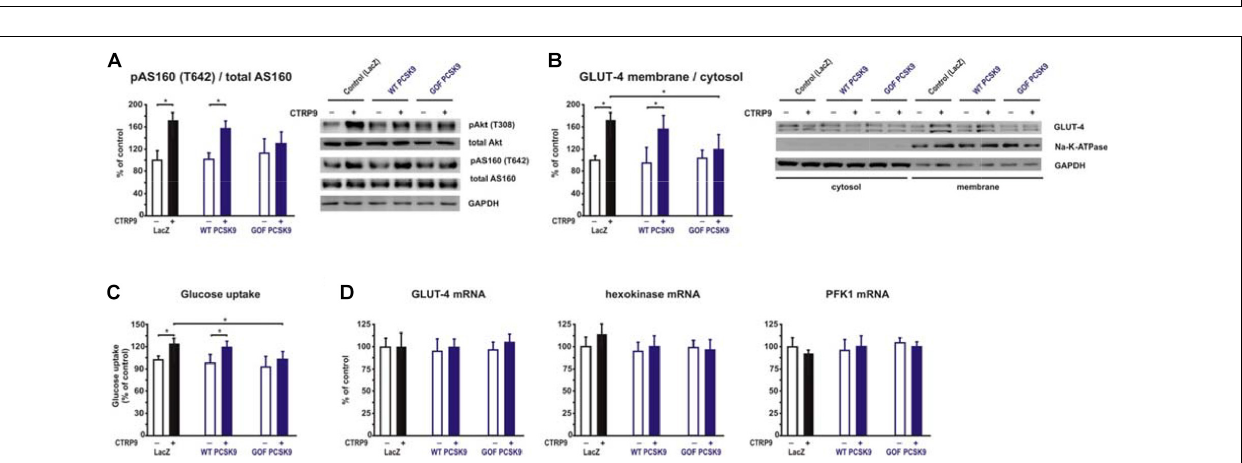
FIGURE 6 | Impact of PCSK9 on CTPR9-induced mitochondrial effects. Adult rat cardiomyocytes were incubated in the presence of LacZ-containing supernatant (control), murine wild-type PCSK9 or GOF PCSK9 (each 0.5 µ g/ml) in serum-free medium for 24 h and subsequently treated with CTRP9 (4 µ g/ml) for 24 h. (A) Changes in PGC1alpha, Tfam, and ND1 mRNA expression were analyzed by Real-time PCR. (B) Genomic DNA was isolated from the cells and afterward analyzed by Real-time PCR for the expression of a mitochondrial transcript and a nuclear transcript in order to estimate mtDNA content. (C) Citrate synthase (CS) activity and the activity of complex I, complex II and complex IV of the respiratory chain were measured in cardiomyocyte lysates. All values were normalized to total protein content of the samples. All data are mean ± SEM, 4 independent experiments, n = 8 per group, * p < 0.05, ** p < 0.01.